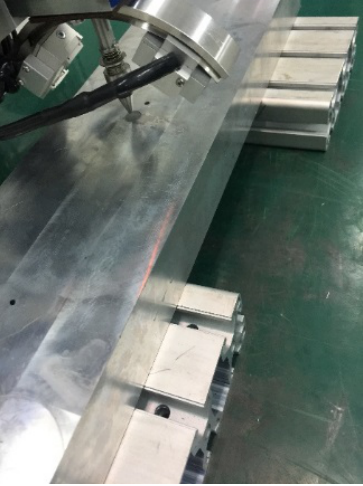
Figure 3. Surface residual stress measurement.